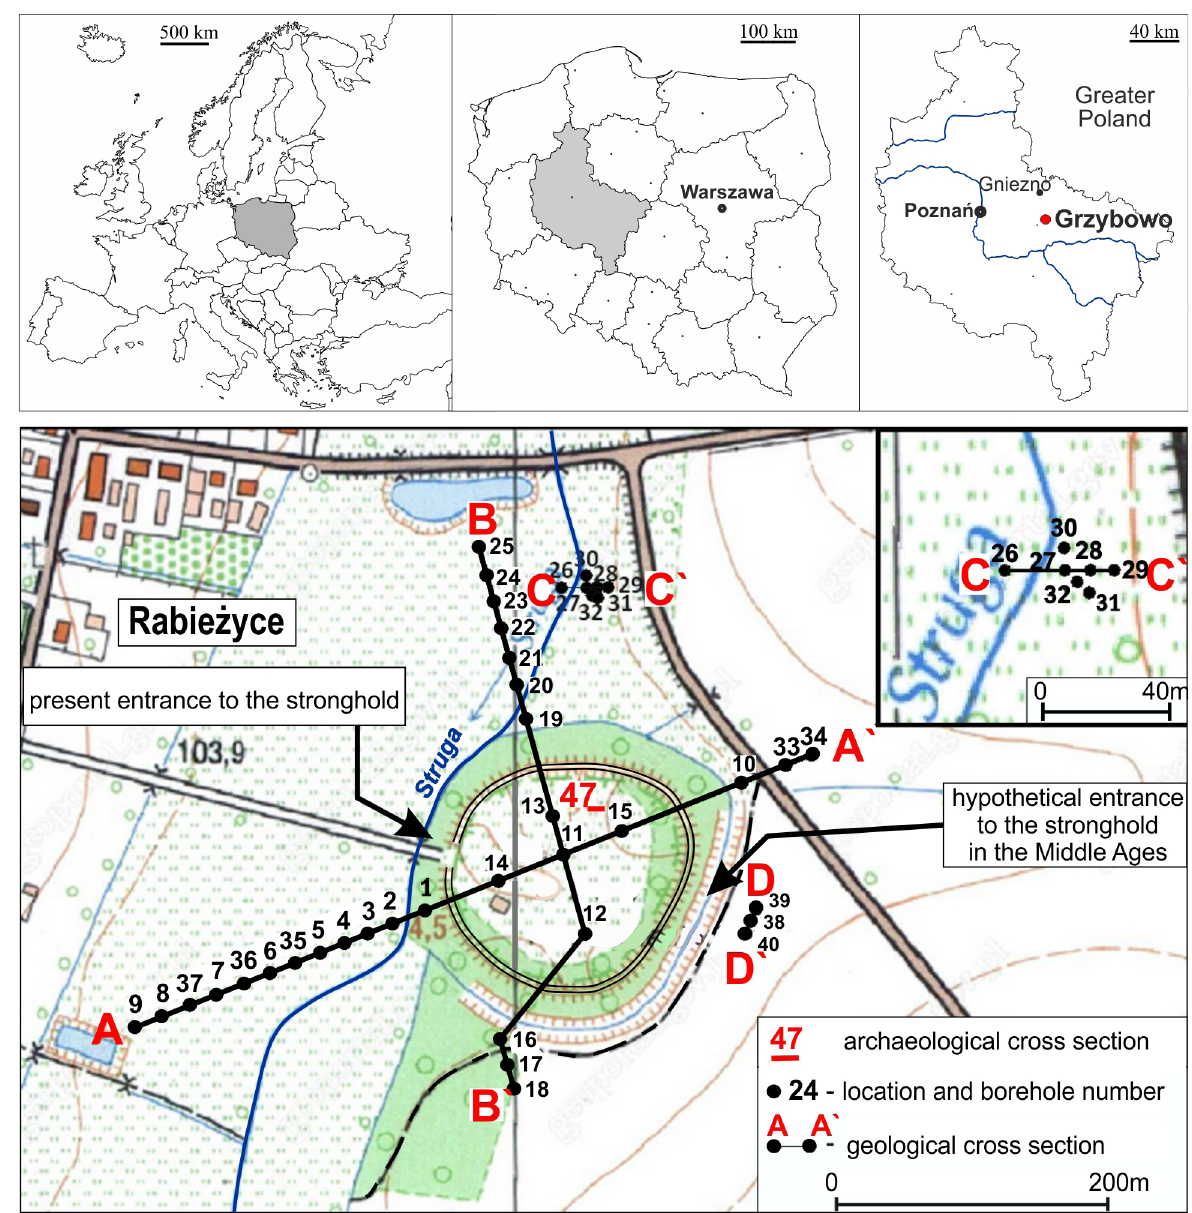
Fig. 1. Location of the study area with marked location of boreholes, cross-section lines of the stronghold area, and archaeological excavation (profile